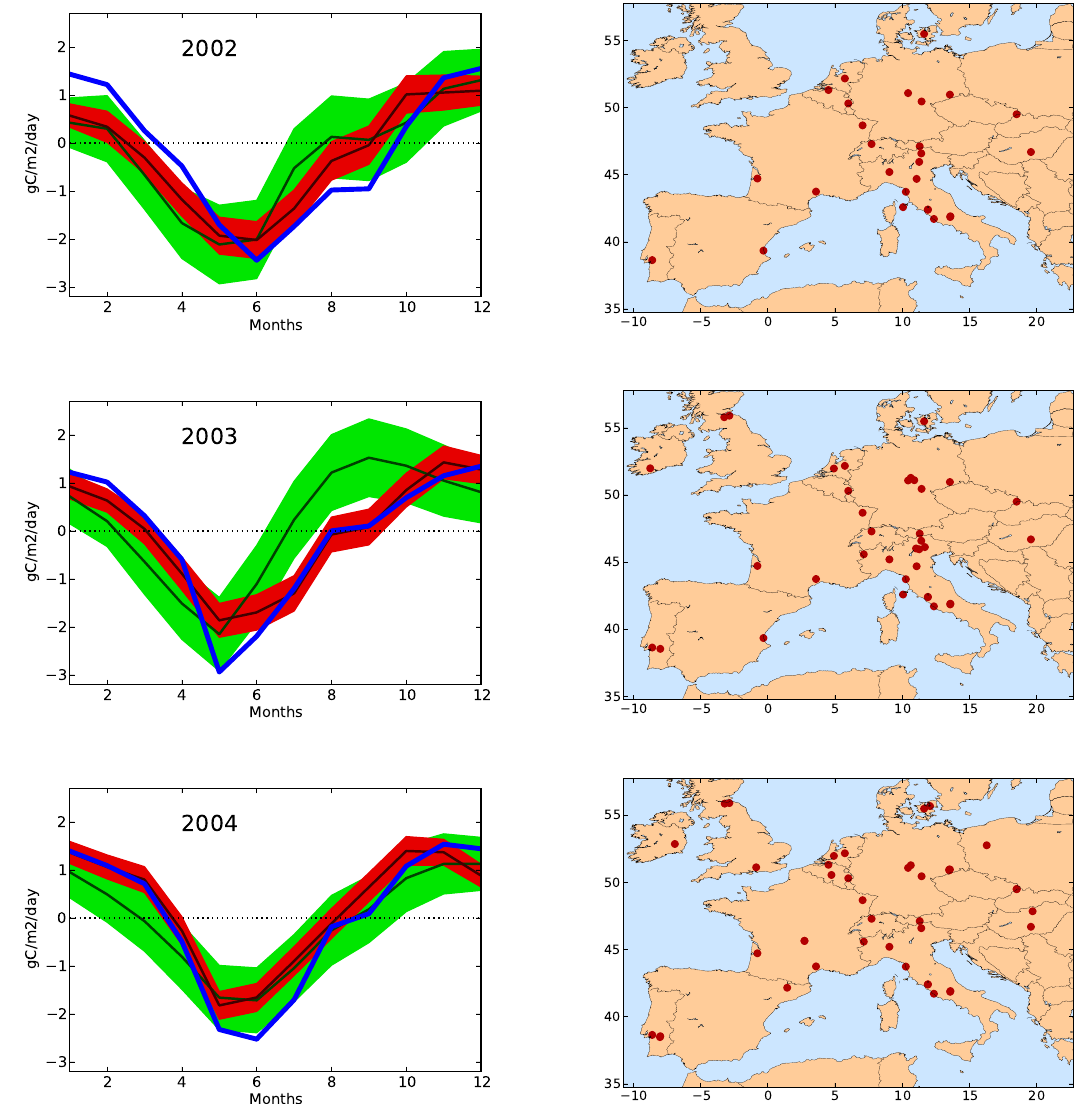
Fig. 2. Temporal evolution of monthly (i.e., 30-day mean) NEE (gCm − 2 day − 1 ; negative values: sink) at the CE-L4 locations specified for a full year in the maps. Blue: CE-L4 data averages; green: ORCHIDEE; red: inverted fluxes; shaded areas: NEE ± standard deviation of the uncertainty in